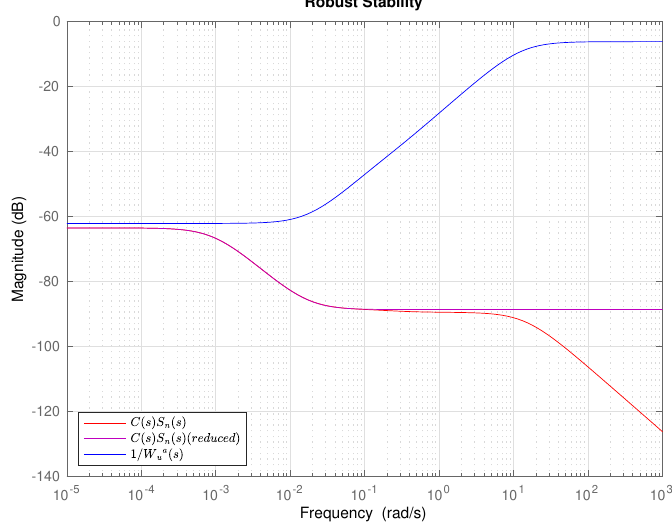
Figure 13. Robust stability